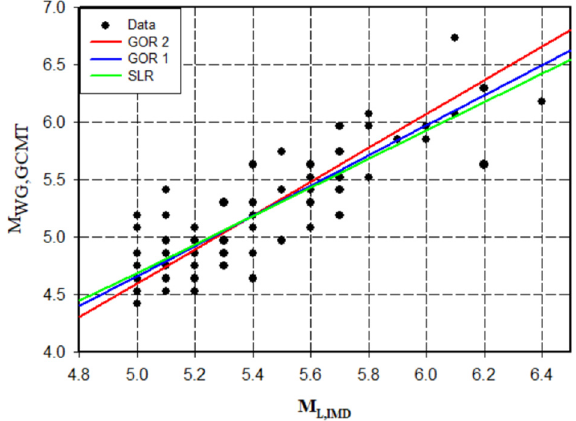
Figure 11. The (M L − M wg ) data, as well as the GOR1, GOR2, and SLR regression lines. The maximum difference between Mw estimations from Ref. [5] and M wg estimations in the present study for local magnitude conversion is found to be 0.3. This difference can be higher than 0.3 while considering a larger magnitude range. The GOR1 relationship for M L to M wg has the highest accuracy in terms of the uncertainty of the regression coefficients when compared to SLR and GOR2 (Figure 12 and Tables 2 and 3).